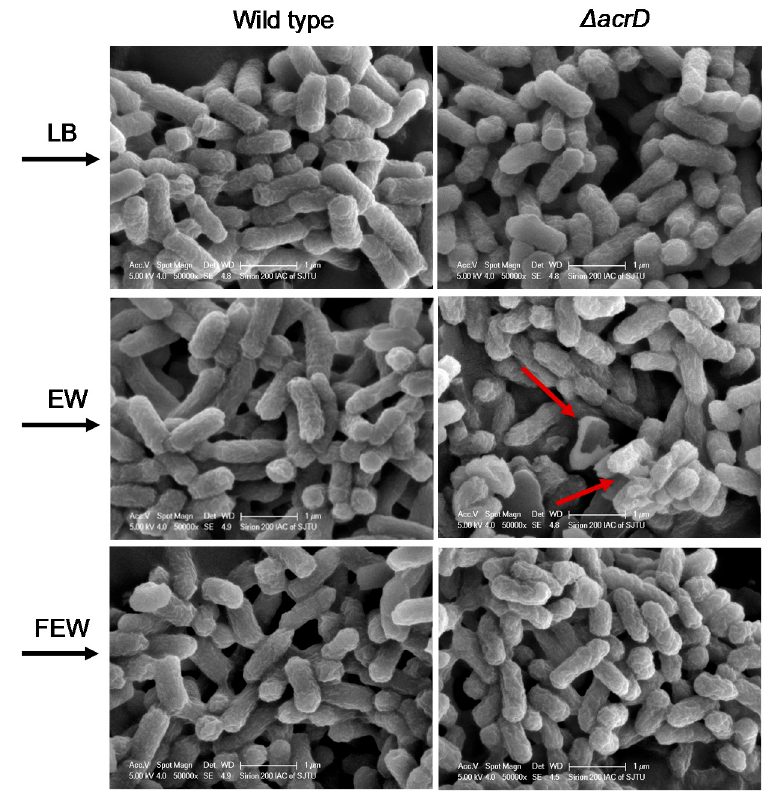
Figure 3. SEM micrographs of S . Enteritidis wild type and Δ acrD mutants in LB broth, egg white (EW) and egg white filtrate (FEW) at 37 °C for 1 day. Red arrows highlight clear examples of morphology changes. Magnification = 50,000×, bar marker = 1 μ m.